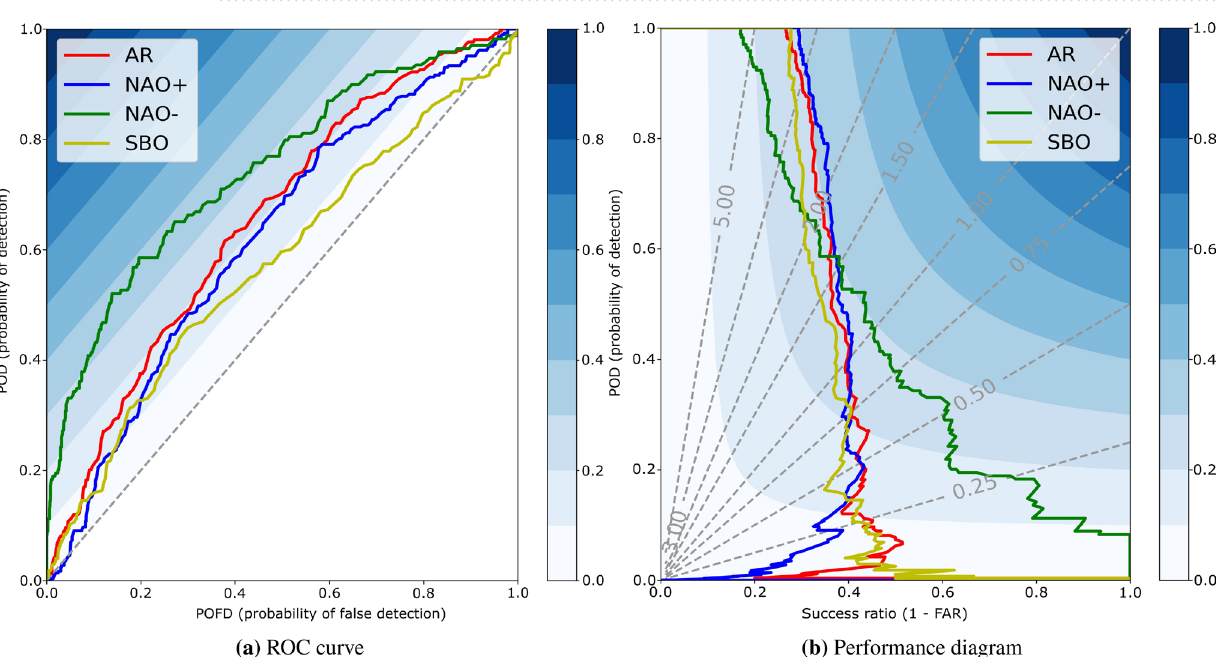
Figure 2. Receiver operating characteristics curve and performance diagram for deCNN when forecasting NAE weather regimes 10 days into the future. The dashed grey lines for ( a ) denote a random model (random chance), which has an AUC of 0.5. The colorbar for ( a ) refers to the Peirce score, defined as POD minus POFD. The dashed gray lines for ( b ) denotes various levels of frequency bias. A frequency bias of 1.0 is considered an unbiased model. The colorbar for ( b ) refers to